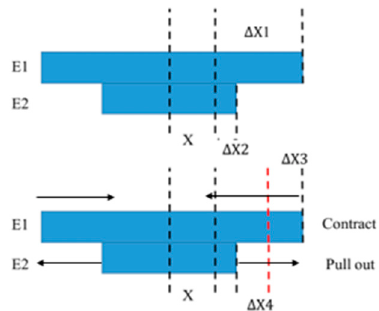
Figure 2. Diagram of the hypothesis of the expansion process of two materials.